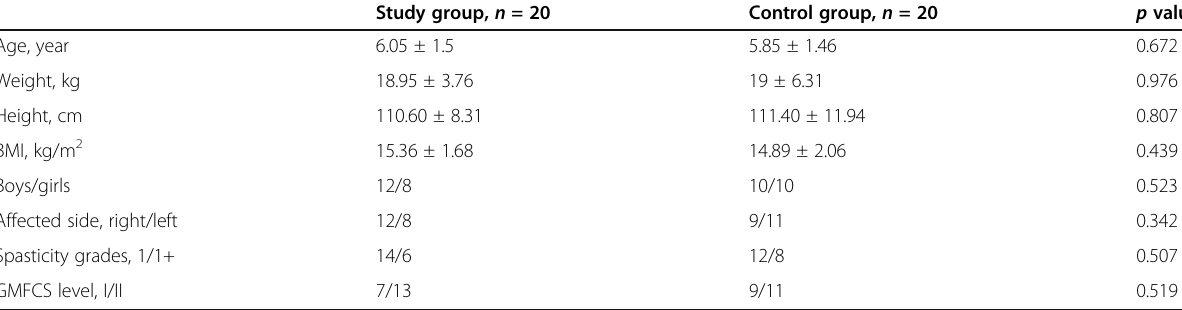
Table 1 Demographic characteristics of the